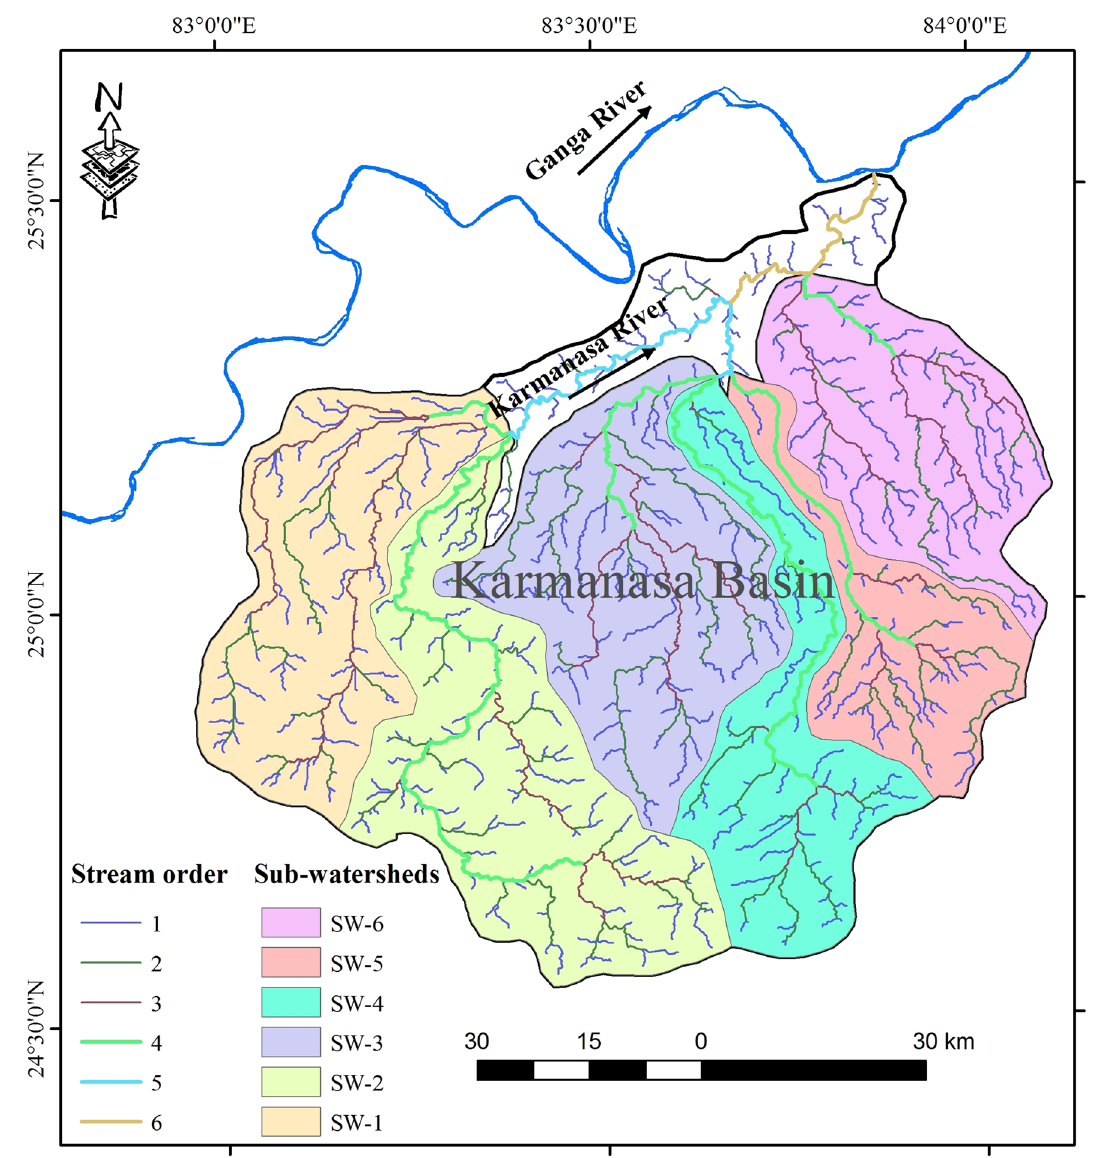
Fig. 3 The drainage of the Karmanasa River basin with six